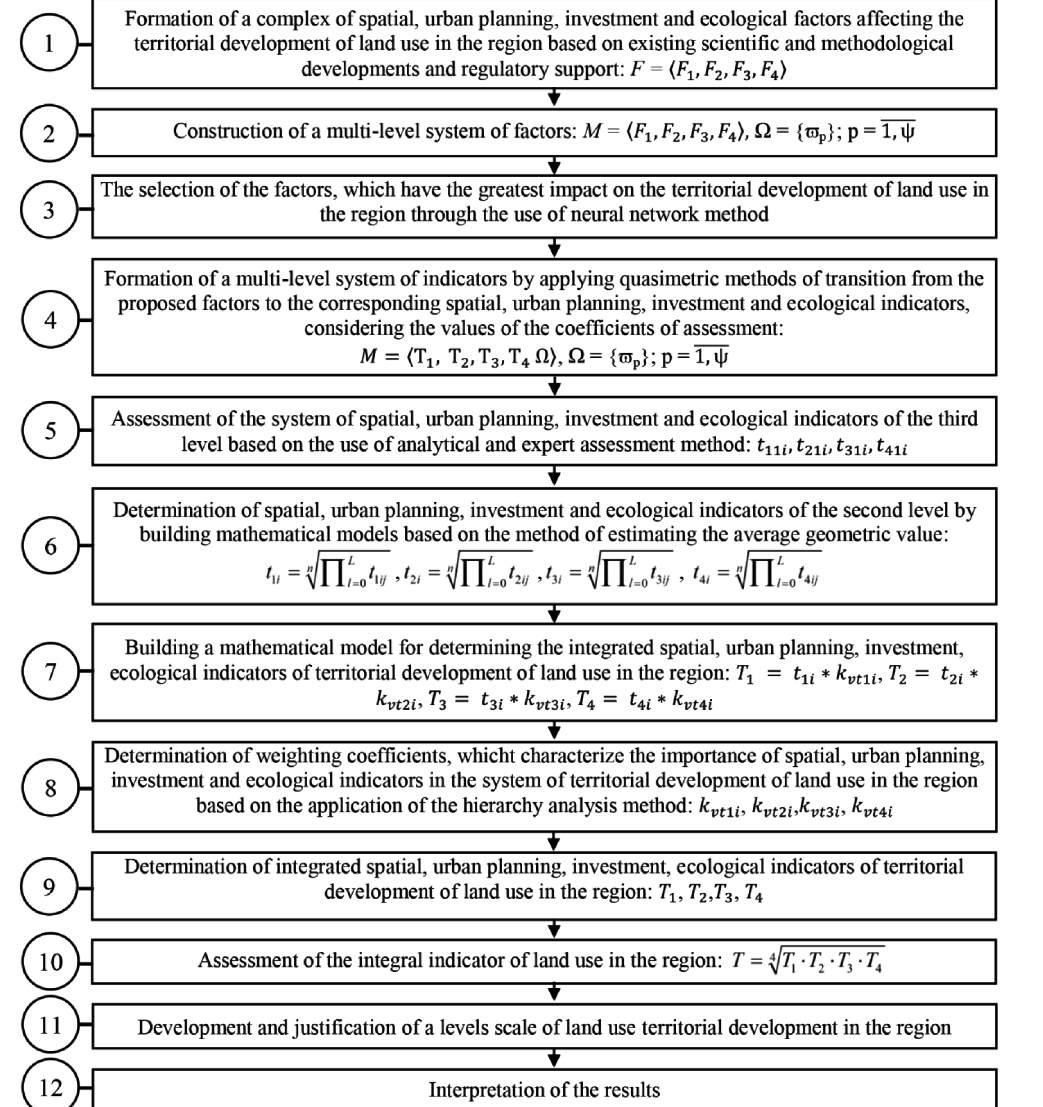
Figure 1. A diagram of the development of a methodological approach to an integrated assessment of the land use territorial development in the